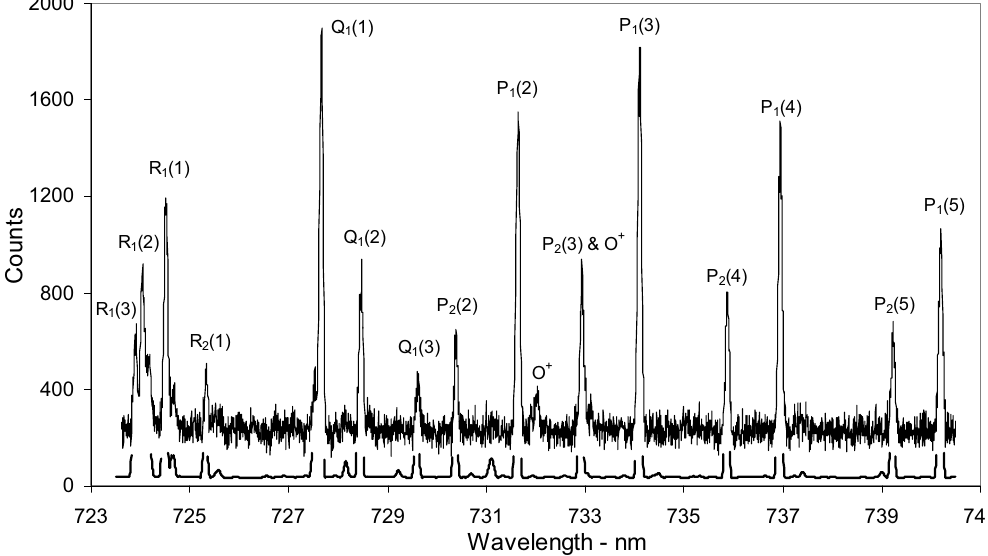
Fig. 1. OH(8–3) hydroxyl airglow (94 summed spectra, clear skies or “thin cloud”, Moon below horizon, no aurora apparent). A theoretical spectrum, plotted below the summed spectrum, indicates the expected thermalized hydroxyl airglow contribution to the background.